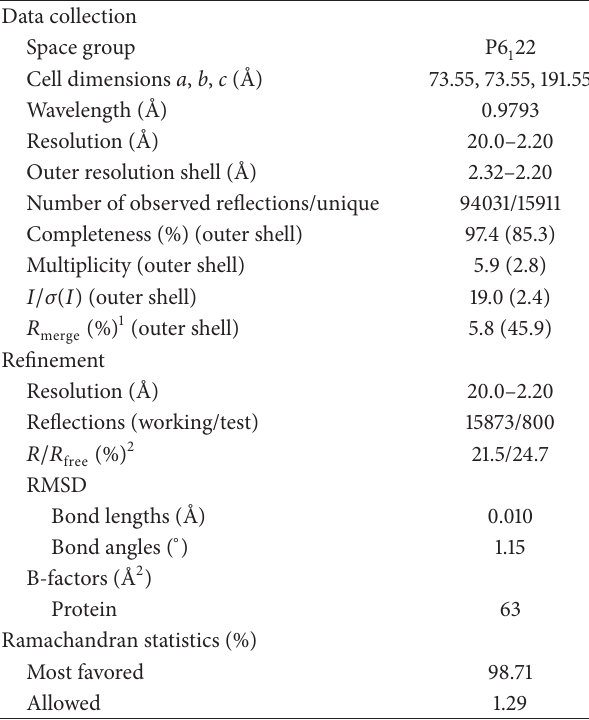
Table 1: Data collection and refinement